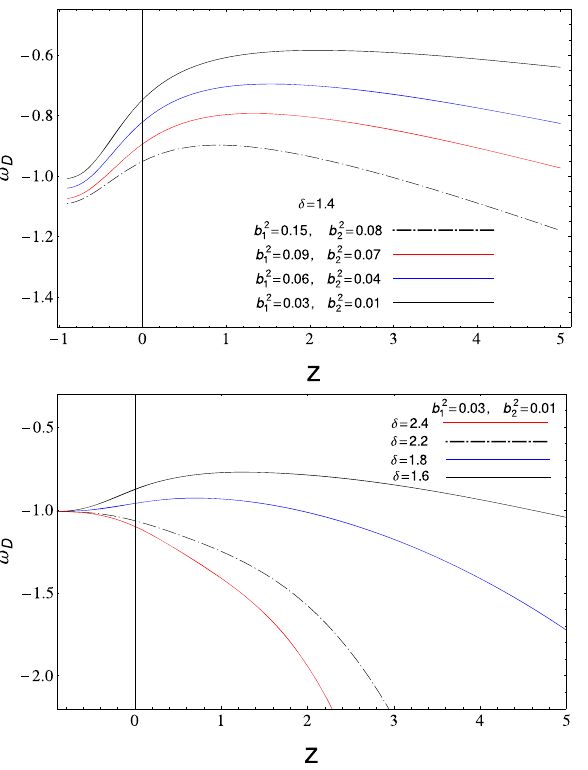
= 0 . 73 D Fig. 3 The evolution of the deceleration parameter q vs. z , is shown = 0 . 73 and different values of b 2 for (cid:5) 0 D panel. Also, the horizontal line denotes q ( z ) = 0